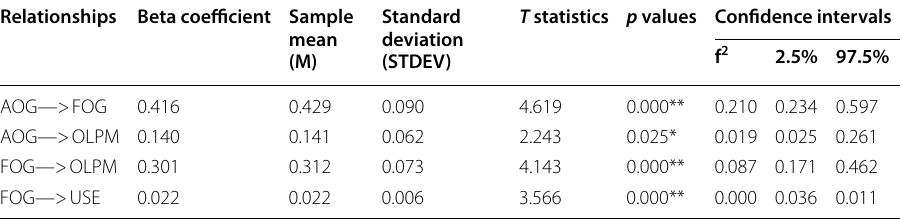
Table 5 Path significance. Source : Field survey (2021)